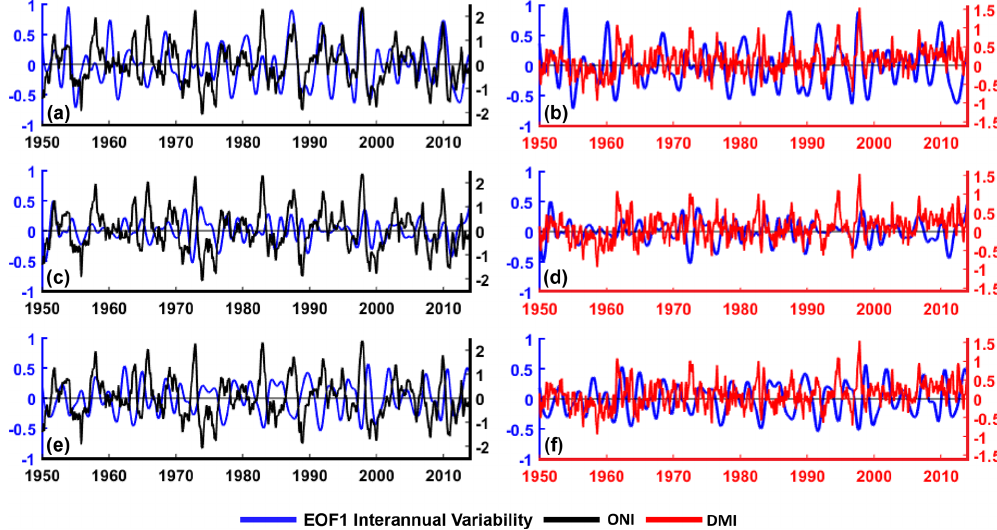
Figure 13. The interannual variability of the EOF first temporal mode (blue lines) overlaid with ONI (black lines) and DMI (red lines) at C EJ (a, b) , A WJ (c, d) , and B SM (e, f) .